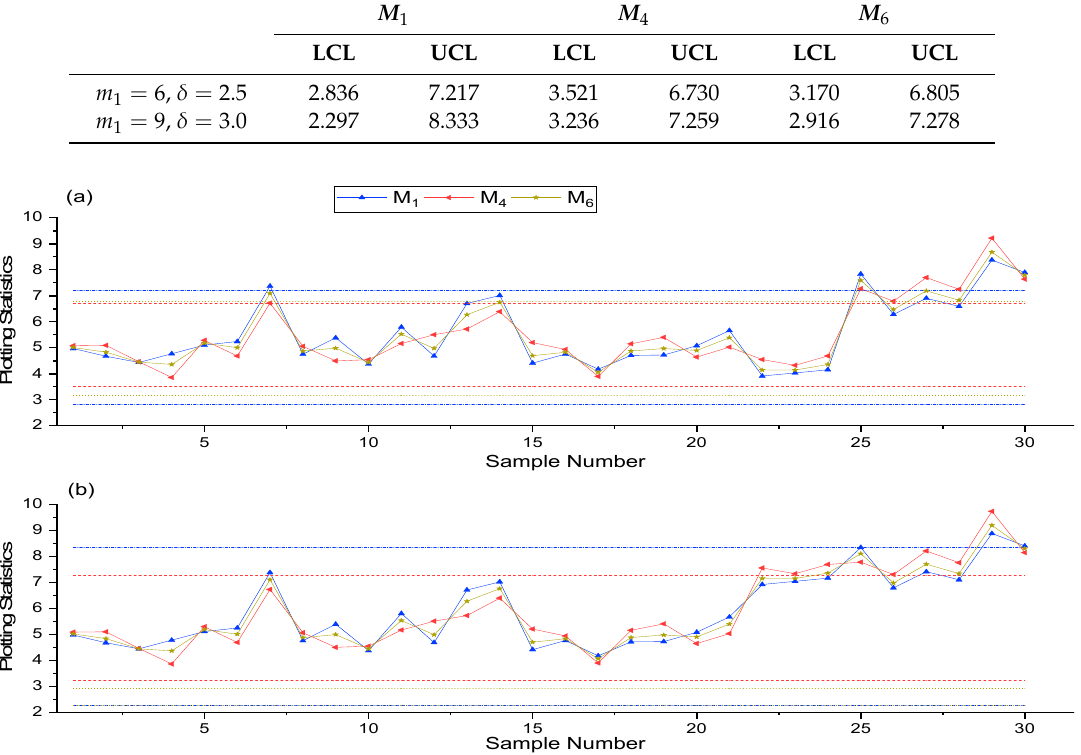
= 9 and 𝛿 = 3.0 (cid:2869)